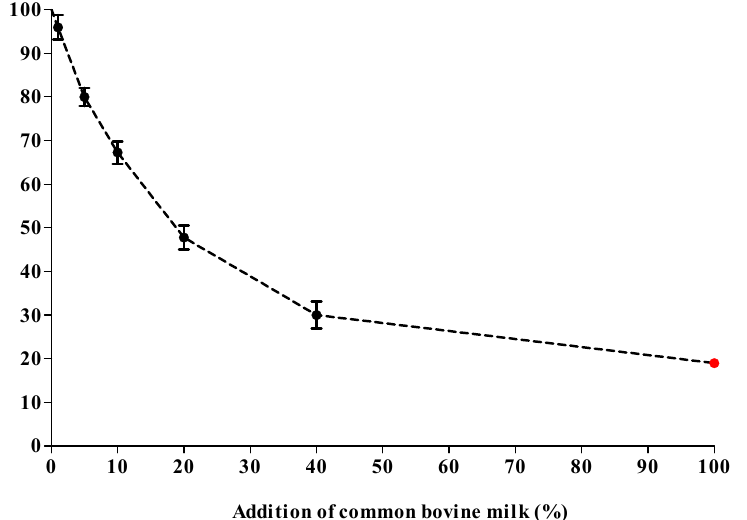
Figure 7. Combined average inhibition responses for the addition of pasteurized A1A2 bovine milk to pure A2A2 milk from sheep, horse, buffalo, goat, donkey, and cow. Each data point, including variation, is the mean value of the combined A2A2 milk samples originating from 6 different spe- cies. The data point for 100% addition of pasteurized A1A2 bovine milk ( ● ) is a single measurement.